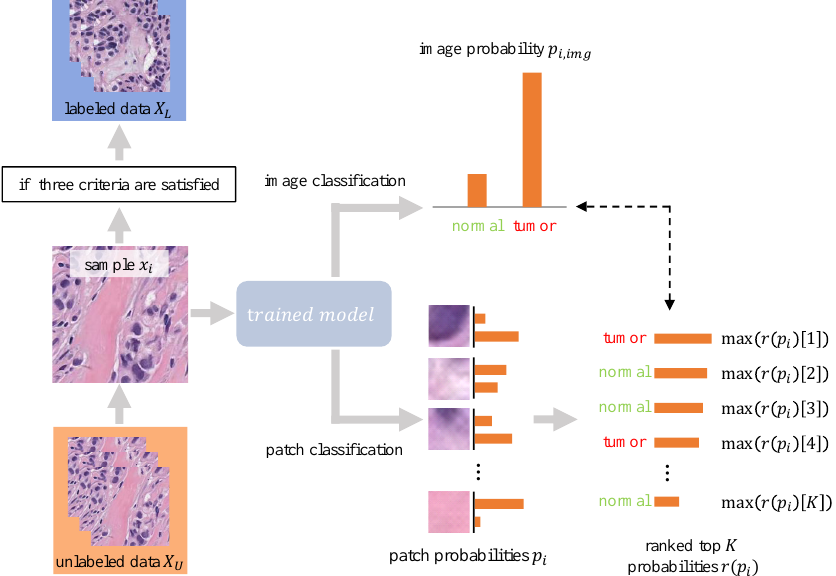
Figure 4. Illustration of the pseudo label generation process. Note that the ranked top K probabilities r ( p i ) only displays the dominant values for each r ( p i )[ k ] , k ∈ [ 1, K ] . For example, if r ( p i )[ k ] is ’tumor’: 0.6, ’normal’: 0.4, then the dominant value of r ( p i )[ k ] is ’tumor’: 0.6. Thus, max ( r ( p i )[ k ]) = 0.6 and argmax ( r ( p i )[ k ]) =